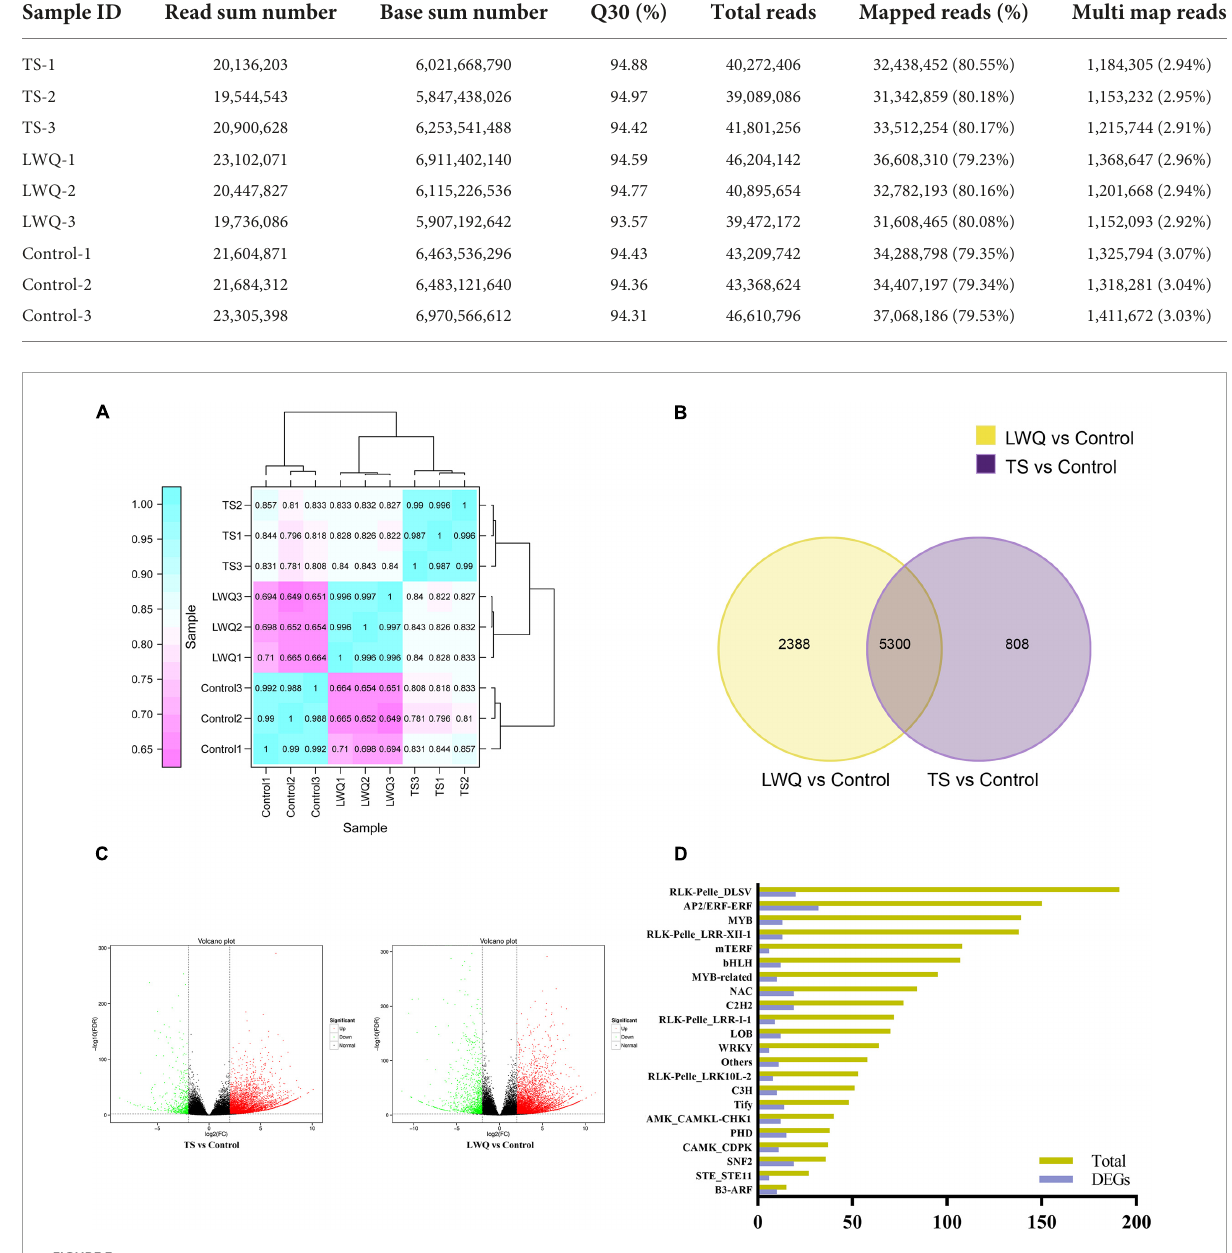
FIGURE3 Global evaluation of transcriptome sequencing data of spruce. (A) Hierarchical clustering analysis of gene expression shown the correlation among samples. (B) Venn diagram of DEGs in compared between TS, LWQ, and control treatments. DEGs were selected using fold change ≥ 4, FDR correction < 0.01. (C) Volcano plot of all detected genes. Red represents upregulation; green represents downregulation; black represents non-differentially expression. (D) TFs differentially expressed under O. bicolor . X -axis represents the number of DEGs, and Y -axis represents the number names of transcription factor family.